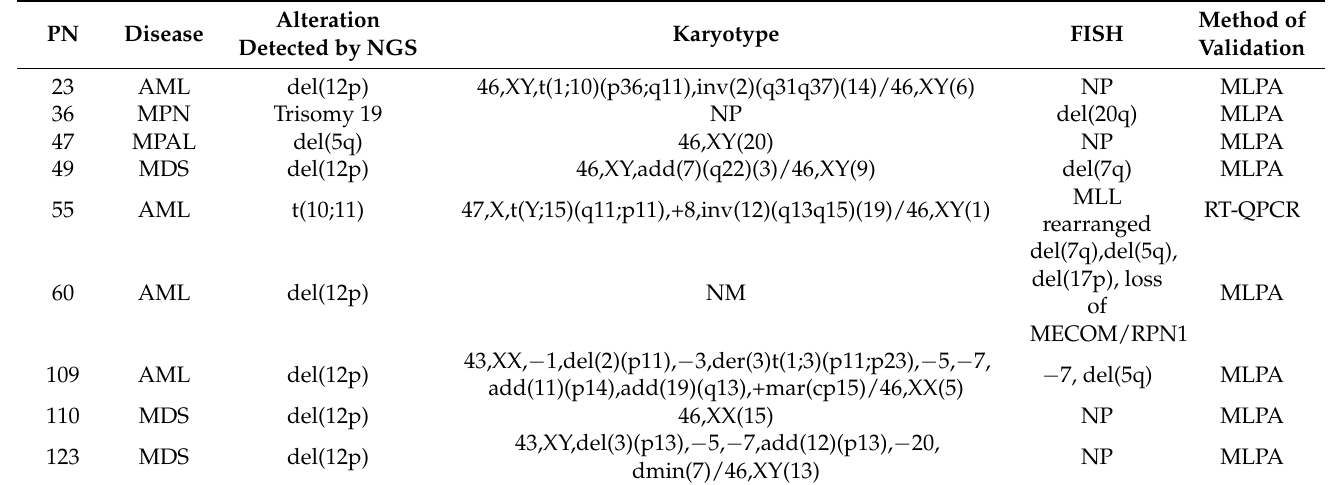
Table 2. Alterations only observed by